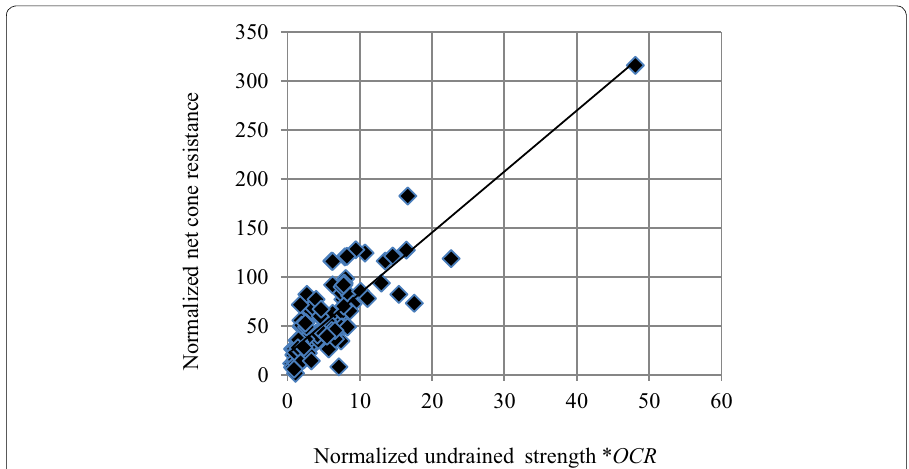
Fig. 7 Relationship of normalized net cone resistance and undrained strength for all